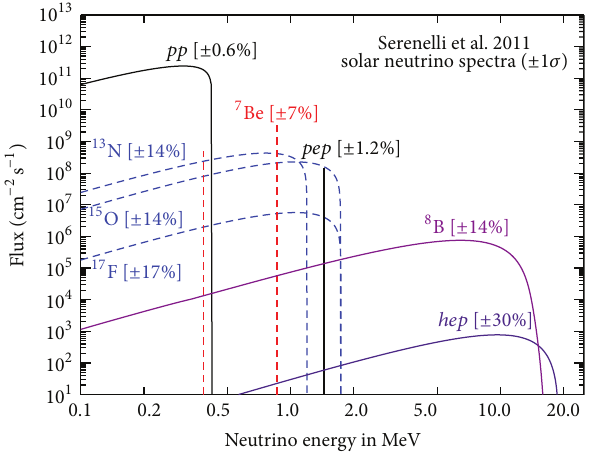
Figure 3: The solar neutrino spectrum predicted by the SSM calculation of [15].